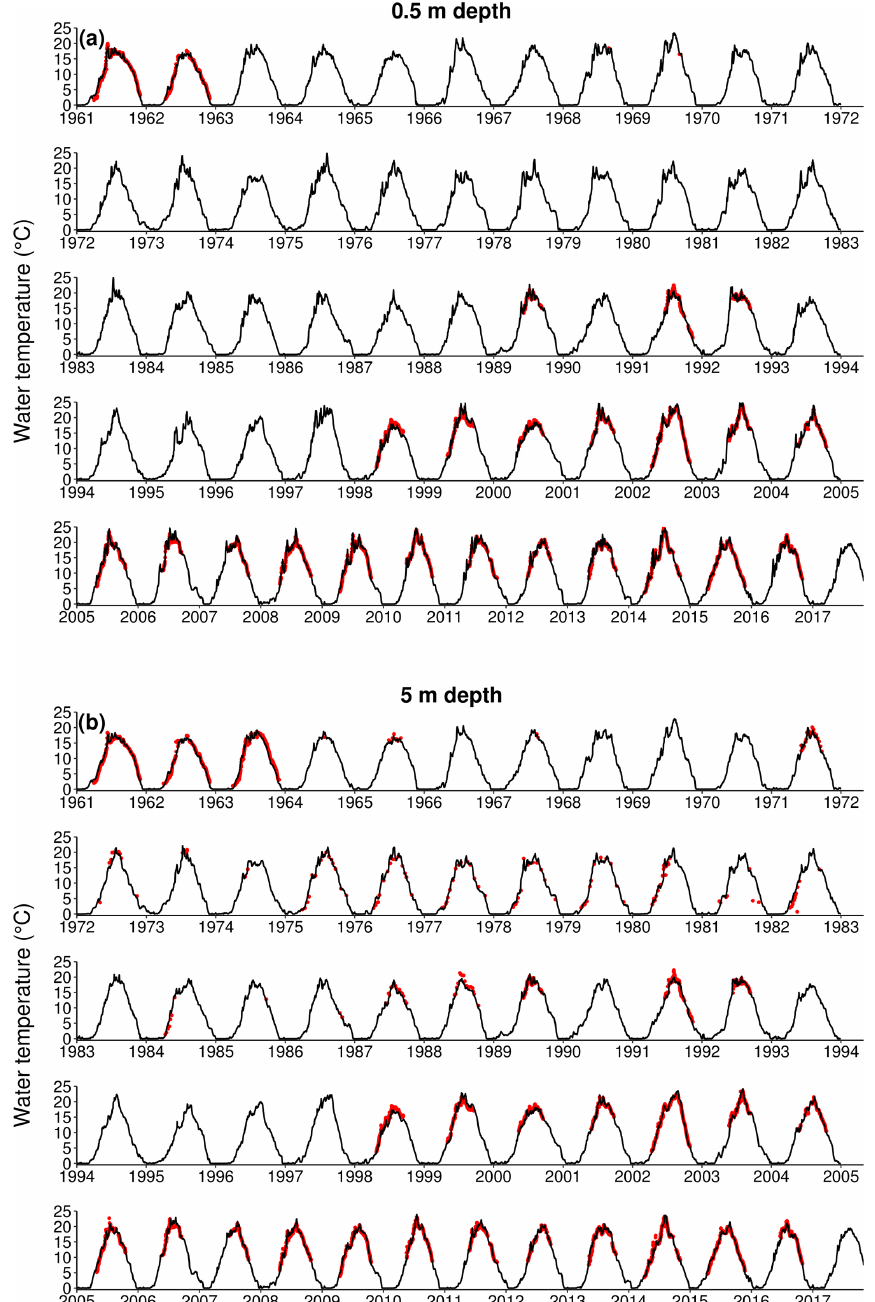
Figure 3. Comparison between Erken modelled (black line) and observed daily temperature (red dots) at 0.5m (a) and 5m (b) depth (0.5m depth: RMSE = 0.827 ◦ C, MAE = 0.614 ◦ C, bias = 0.086 ◦ C; 5m depth: RMSE = 0.840 ◦ C, MAE = 0.618 ◦ C, bias =− 0 . 004 ◦